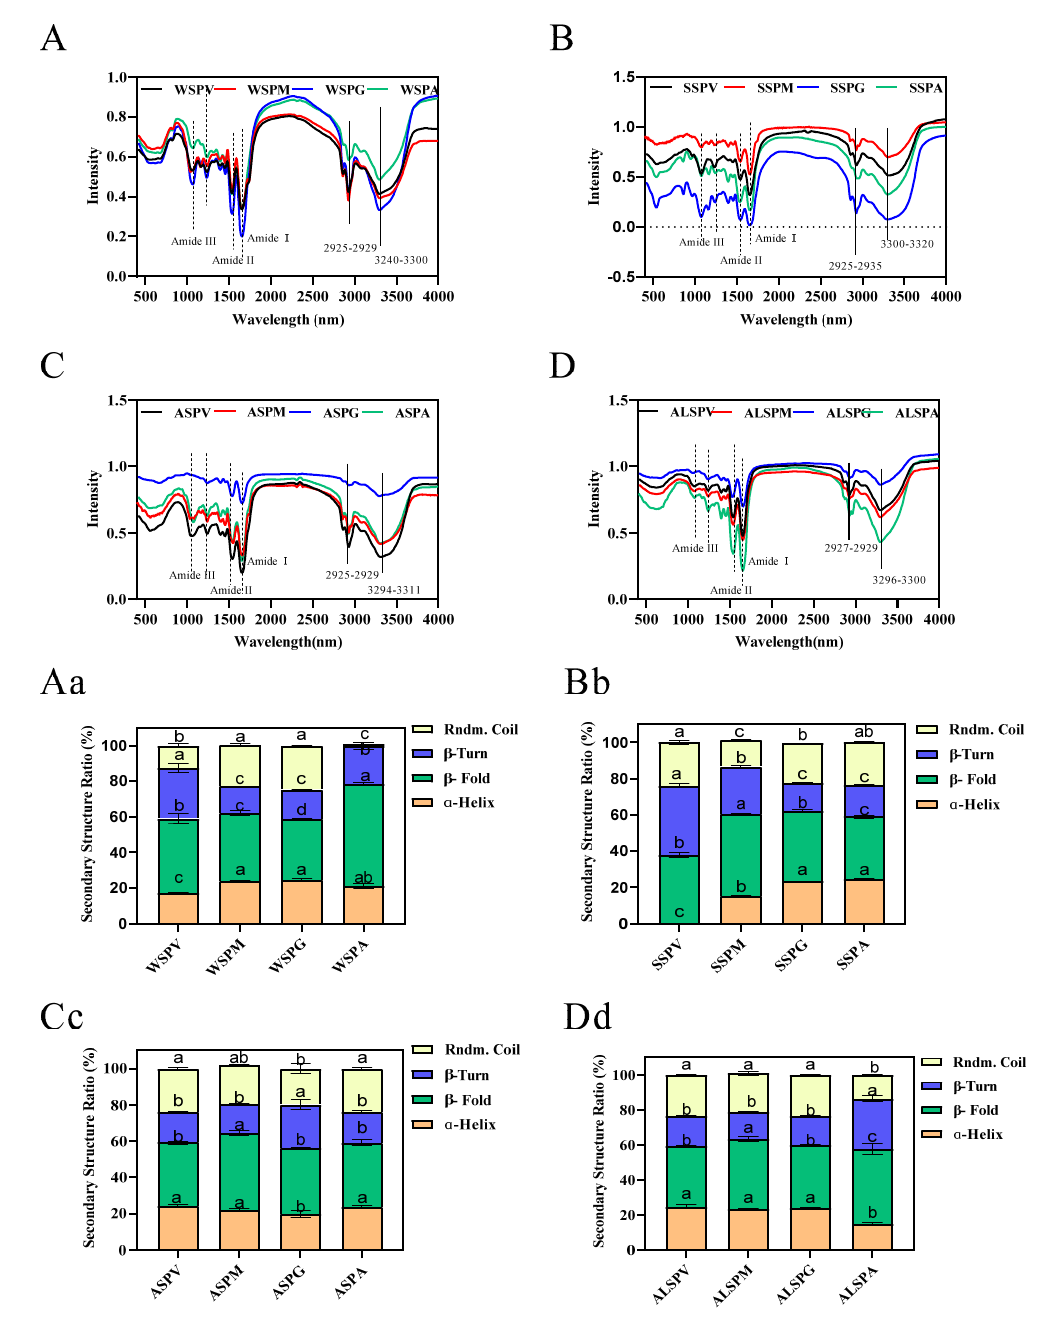
Figure 5. FTIR spectra and secondary structure of oyster proteins extracted from various parts. Figure 5 ( A – D ) showed the FTIR spectras of WSP, SSP, ASP and ALSP in different parts of oyster, respectively. Figure 5 ( Aa – Dd ) showed the secondary structure profiles of WSP, SSP, ASP and ALSP in different parts of oyster, respectively. Different superscripts in the same color indicate the significant differences ( p < 0.05).